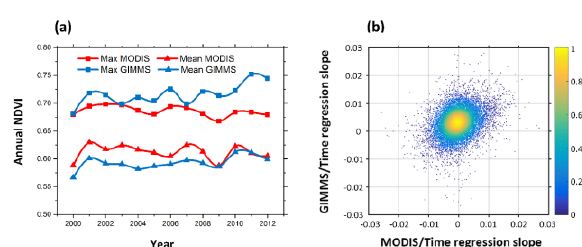
Figure S6. The inter-comparison of change trend between GIMMS NDVI3g and MODIS NDVI during the overlapped period (2000-2012). (a) Annual maximum and mean crop NDVI change trend derived from GIMMS and MODIS datasets; and (b) Density scatterplot (global) of regression slope values from linear regression trend analysis of annual maximum MODIS NDVI and time period 2000-2012 against that of annual GIMMS NDVI and time period 2000-2012.